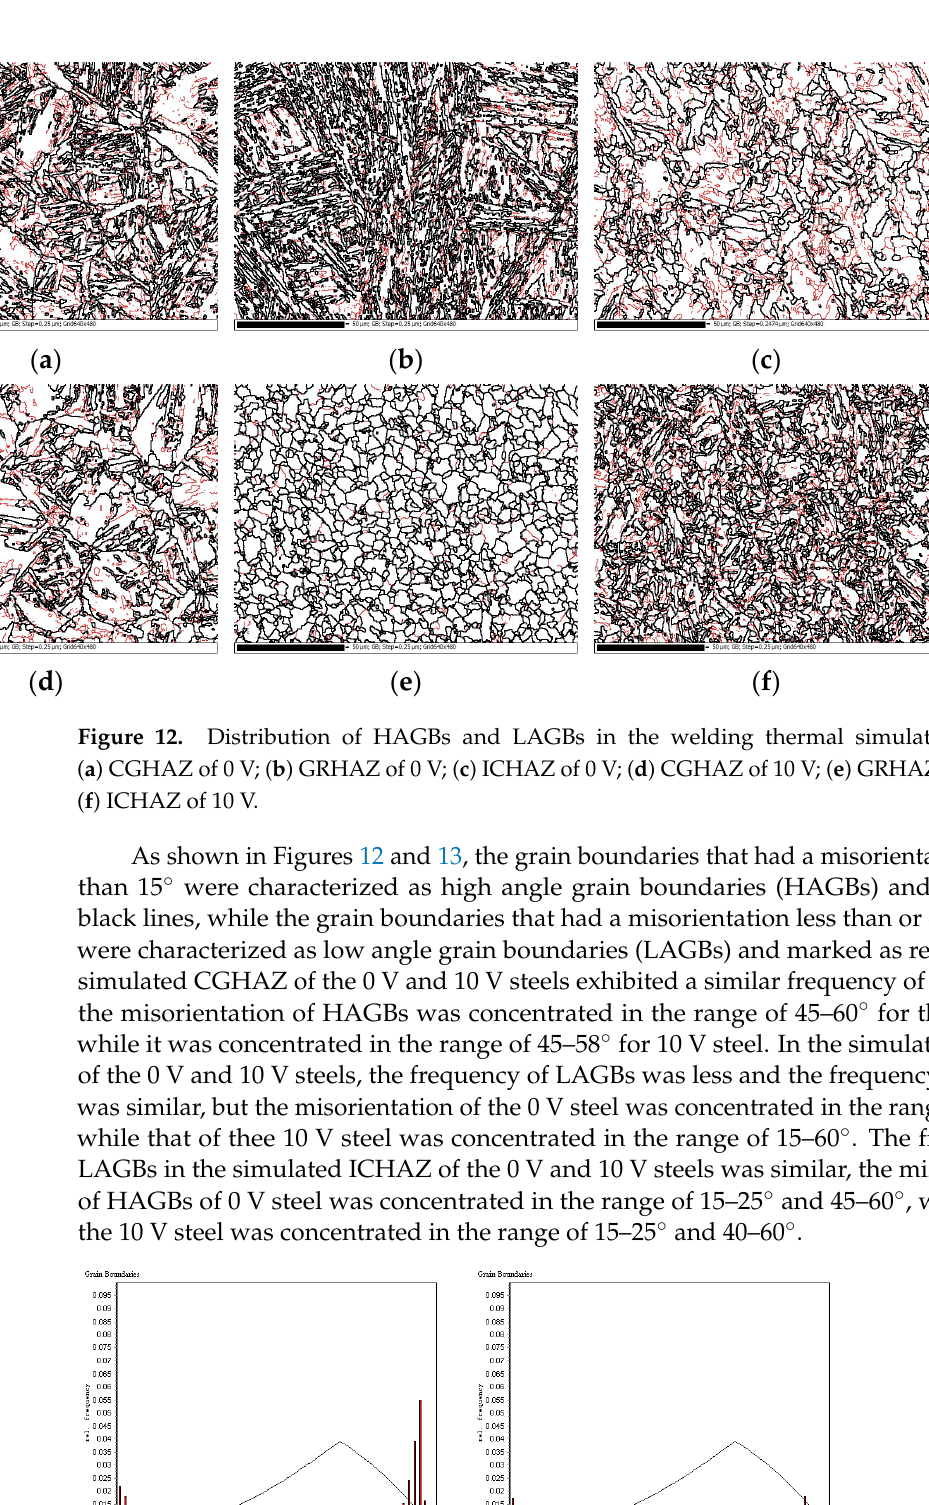
14 of 21 Figure 11. IPF maps of the welding thermal simulation samples: ( a ) CGHAZ of 0 V; ( b ) GRHAZ of 0 V; ( c ) ICHAZ of 0 V; ( d ) CGHAZ of 10 V; ( e ) GRHAZ of 10 V; and ( f ) ICHAZ of 10 V; ( g ) crystal- lographic orientation illustration. As shown in Figures 12 and 13, the grain boundaries that had a misorientation greater than 15° were characterized as high angle grain boundaries (HAGBs) and marked as black lines, while the grain boundaries that had a misorientation less than or equal to 15° were characterized as low angle grain boundaries (LAGBs) and marked as red lines. The simulated CGHAZ of the 0 V and 10 V steels exhibited a similar frequency of LAGBs, but the misorientation of HAGBs was concentrated in the range of 45–60° for the 0 V steel, while it was concentrated in the range of 45–58° for 10 V steel. In the simulated GRHAZ of the 0 V and 10 V steels, the frequency of LAGBs was less and the frequency of